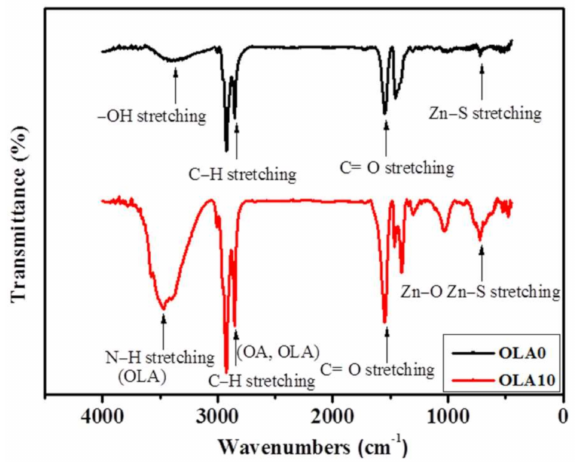
Figure 8. FTIR spectra of QDs with different OLA content (0 and 10